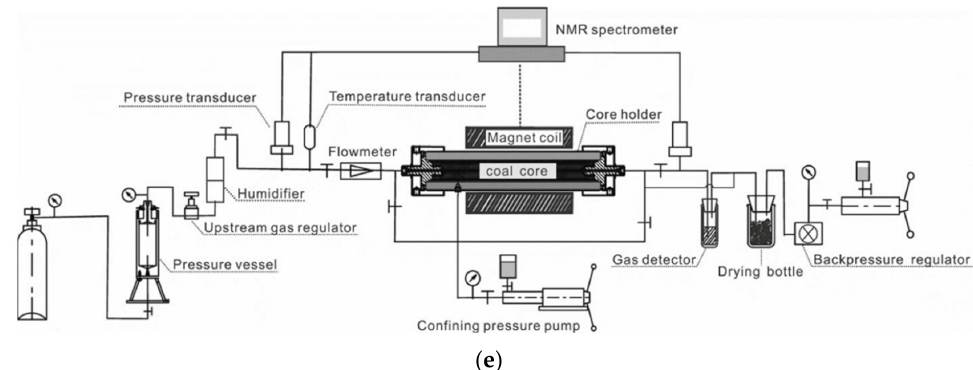
Figure 8. Schematic diagram of relative permeability testing apparatuses. ( a ) Volumetric technique